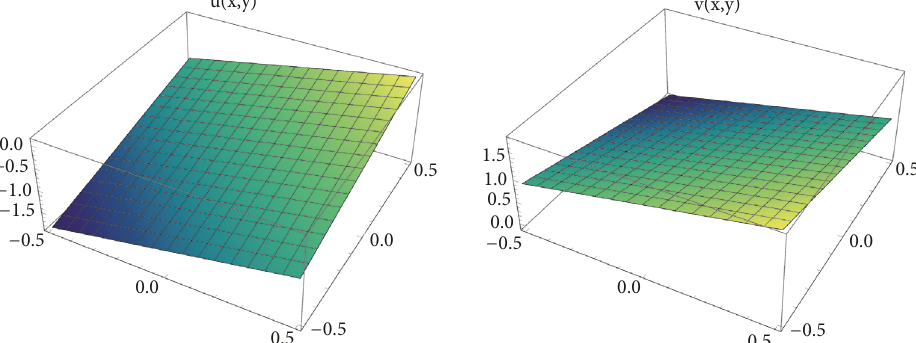
Figure 2: The exact solution of Example 9 for 𝛼 = 0.99 and t =